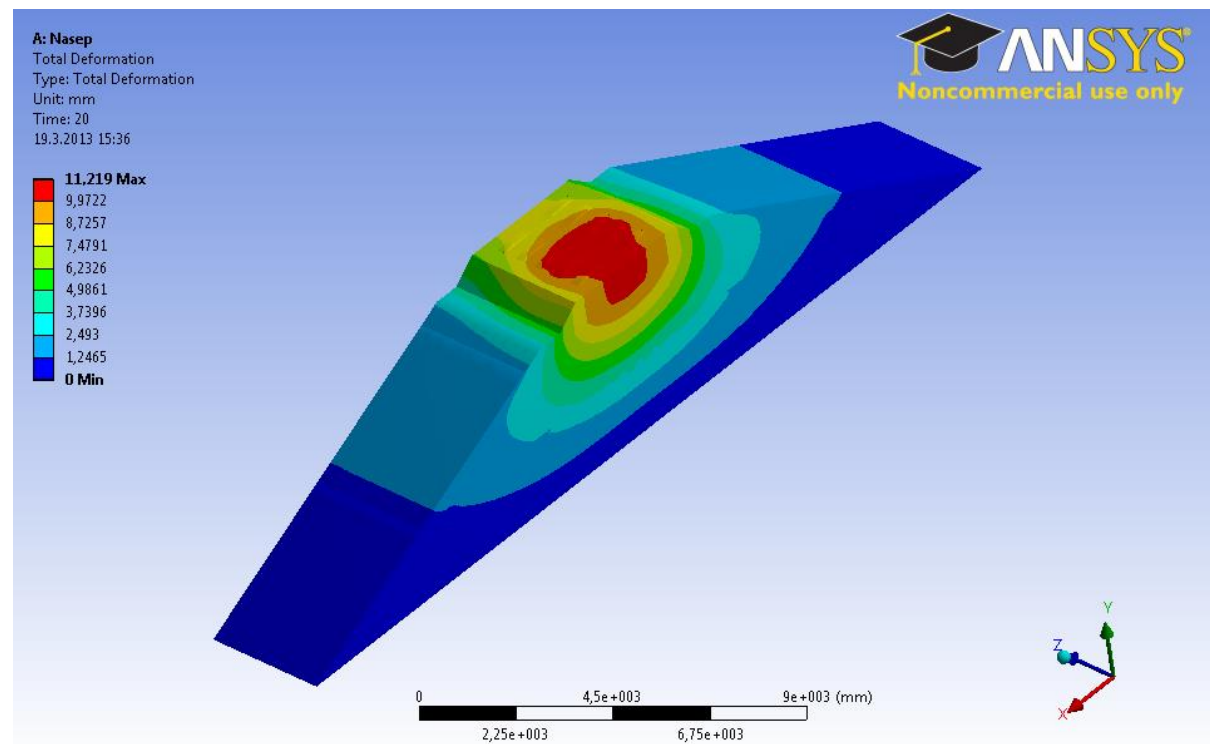
Figure 9. Total deformation of the non-reinforced embankment.